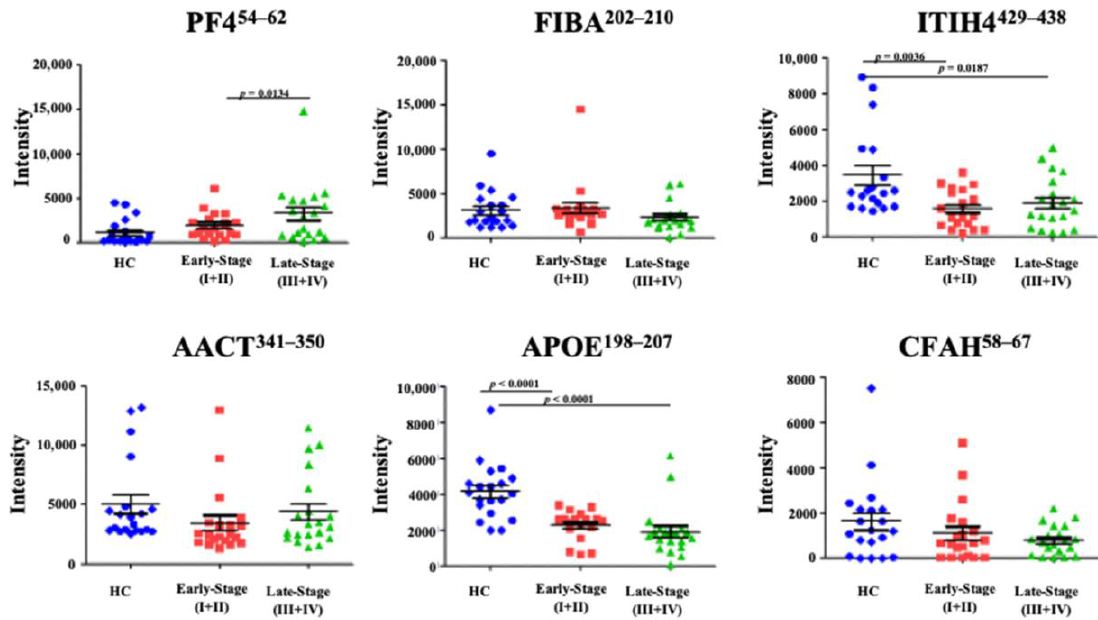
Figure 1. Dot plots of plasma concentrations of selected peptides corresponding to wheat germ agglutinin (WGA)- captured proteins: ADL S* GITGAR (Alhpa-1-antichymotrypsin, AACT 341–350 ), HITSLEVIK (Platelet factor 4, PF4 54–62 ), LALDNGGLAR (Inter-alpha-trypsin inhibitor heavy chain 4, ITIH4 429–438 ), LGPLVEQGR (Apolipoprotein E, APOE 198–207 ), QLEQVIAK (Fibrinogen alpha chain, FIBA 202–210 ), and SLG N* VIMVCR (Complement factor H, CFAH 58–67 ) in 20 paired healthy control (HC), early-stage colorectal cancer (CRC), late-stage CRC samples. The intensity was normalized with peak area of spiked Bovine serum albumin (BSA). p < 0.0167 was considered statistically